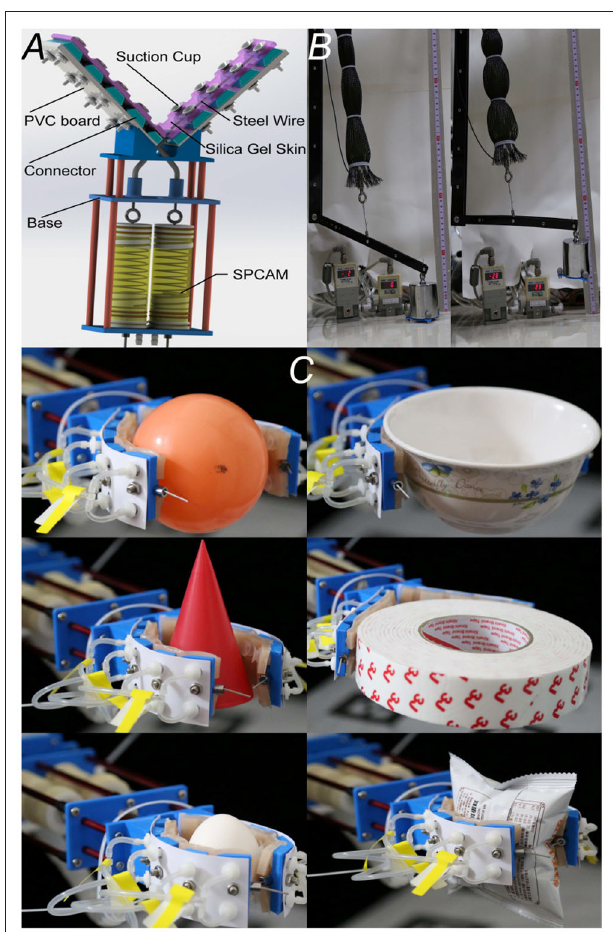
FIGURE 9 | The applications of Self-sensing Pneumatic Compressing Artificial Muscle (SPCAM). (A) The structural schematic diagram of the two-finger dexterous robot hand. (B) The application of positive–negative pressure combined SPCAM on a robotic joint as exoskeleton equipment, resembling human’s muscles. (C) Demonstration of the dexterous gripper when grasping different target objects, including fragile and soft ones. From left to right, top to bottom, are rubber ball, bowl, cone, tape, raw egg, and puffed food bag,